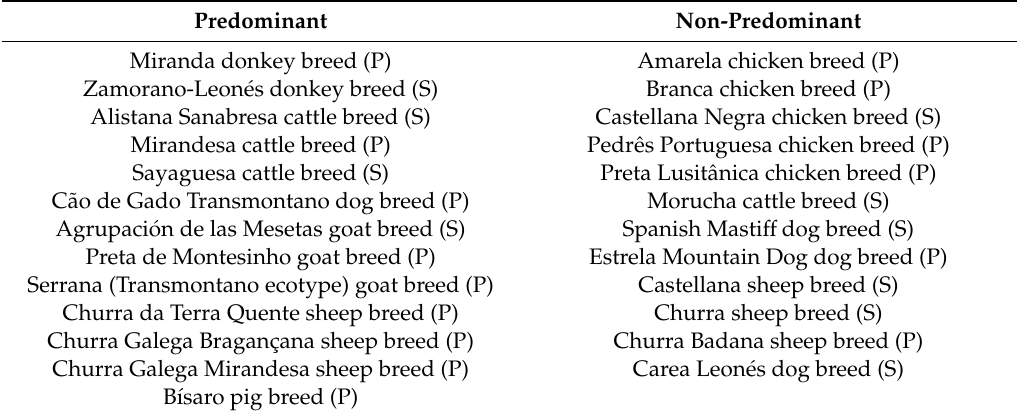
Table 1. List of documented breeds of the MITBR in Portugal (P) and Spain